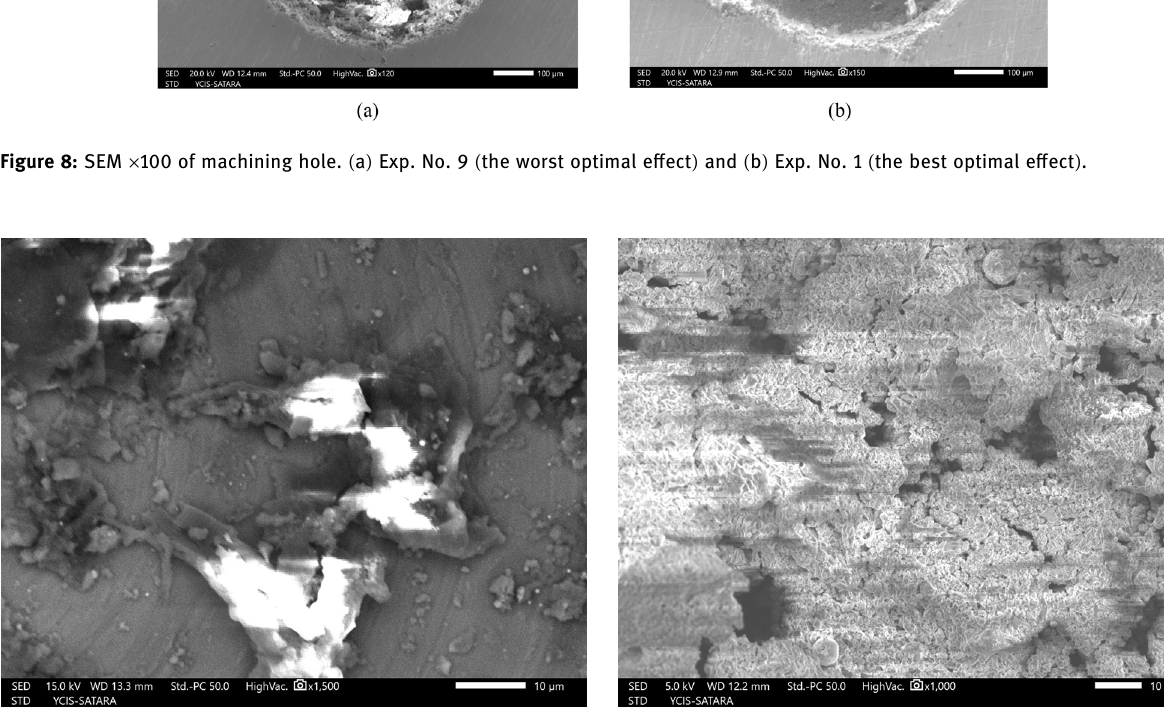
Figure 9: Topography of machined surface. Figure 10: Cracks on machined